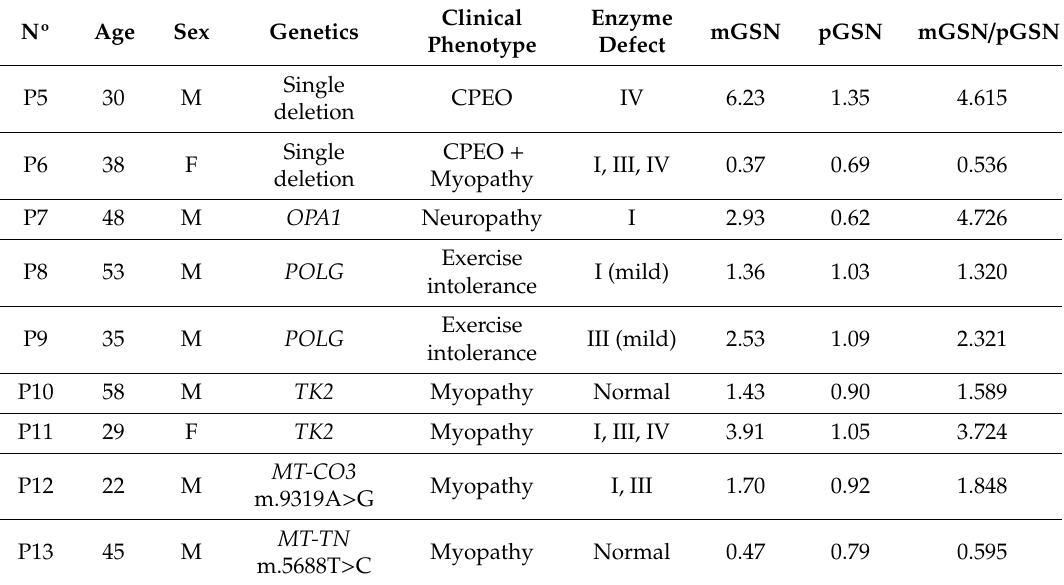
Table 1. Clinical features of 9 adult patients with mitochondrial OXPHOS disease (MD).